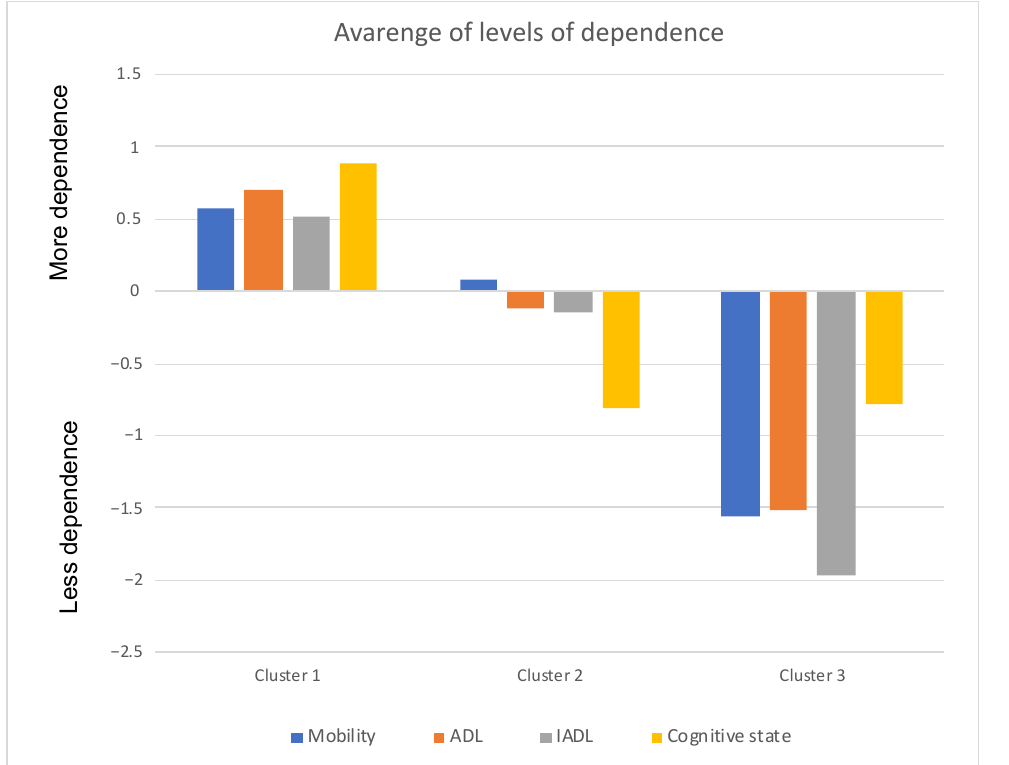
Figure 2. Mean of the dependence levels of Cluster 1, Cluster 2 and Cluster 3 of the Long Term Care and Maintenance Units. J. Pers. Med. 2022 , 12 , x FOR PEER REVIEW